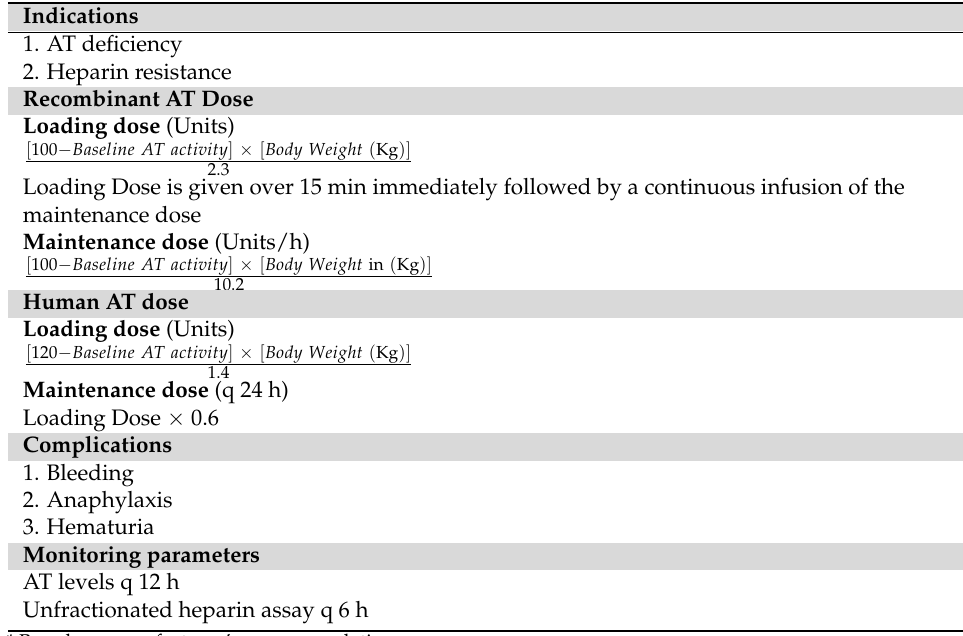
Table 1. Human and recombinant Antithrombin (AT) indication, dose, complications & monitoring parameters *.